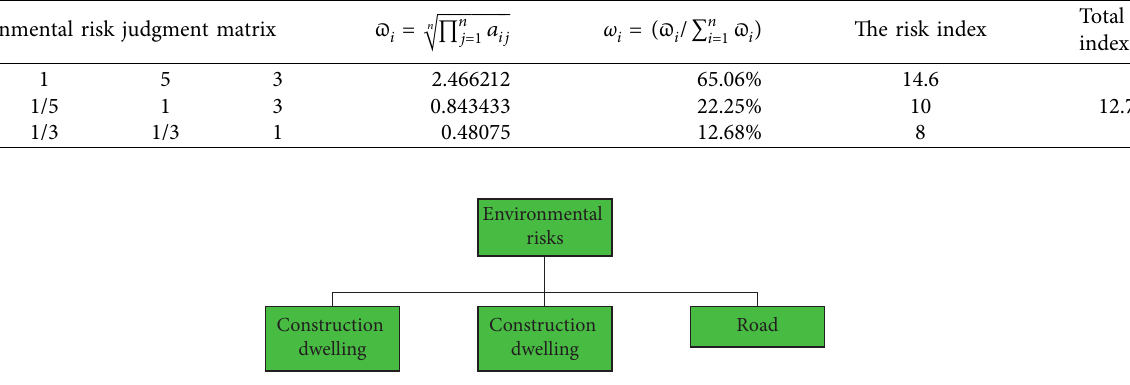
Figure 8: Environmental risk hierarchy. Table 42: Poor geological risk judgment matrix.